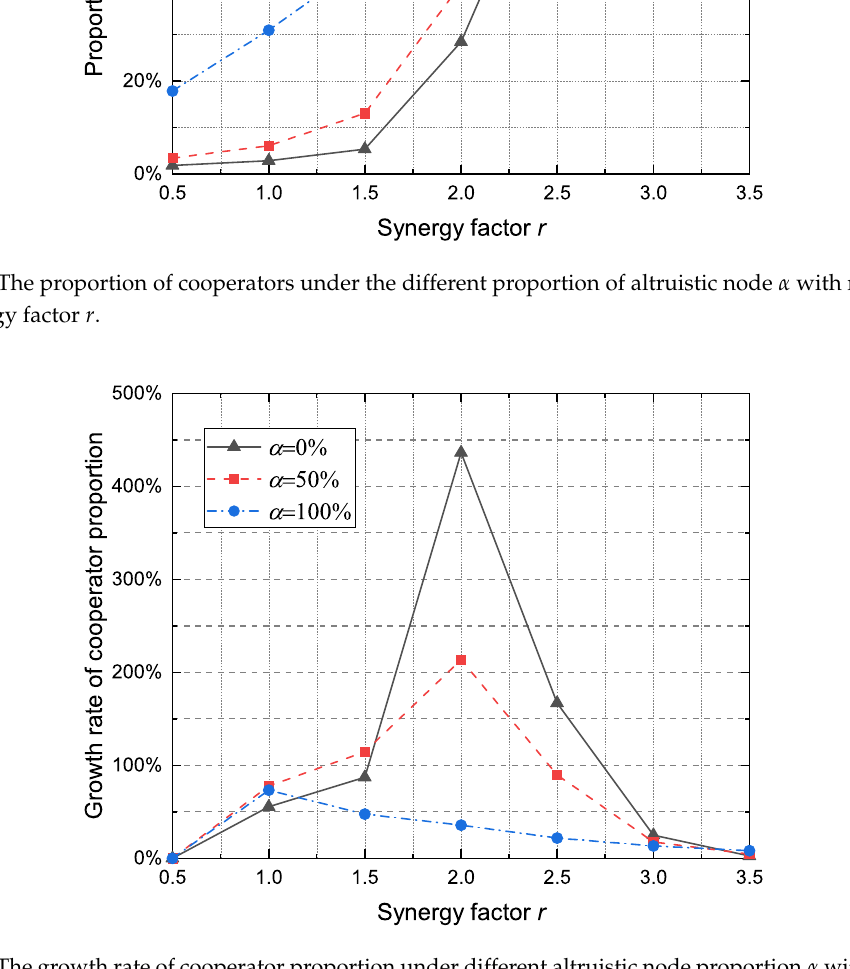
Figure 7. The growth rate of cooperator proportion under different altruistic node proportion α with respect to the synergy factor r